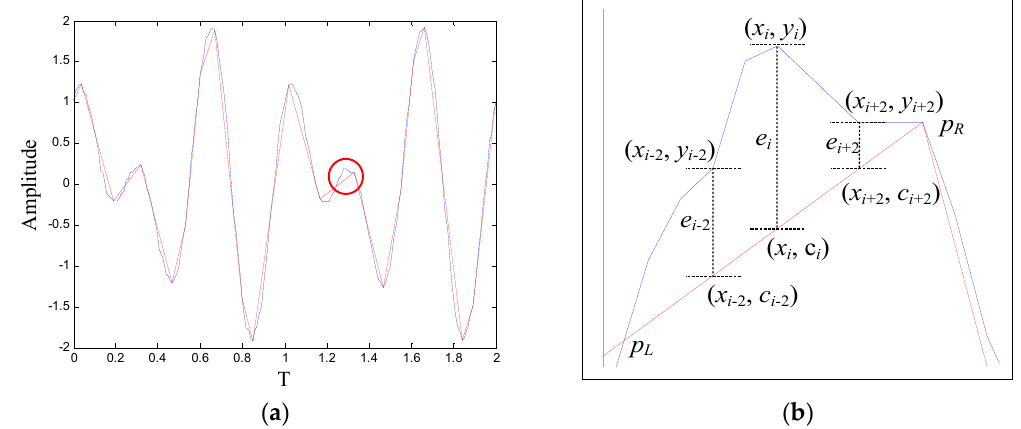
Figure 3. ( a ) Schematic diagram of reconstruction error calculation; ( b ) Local enlarge of the marked region in ( a ).